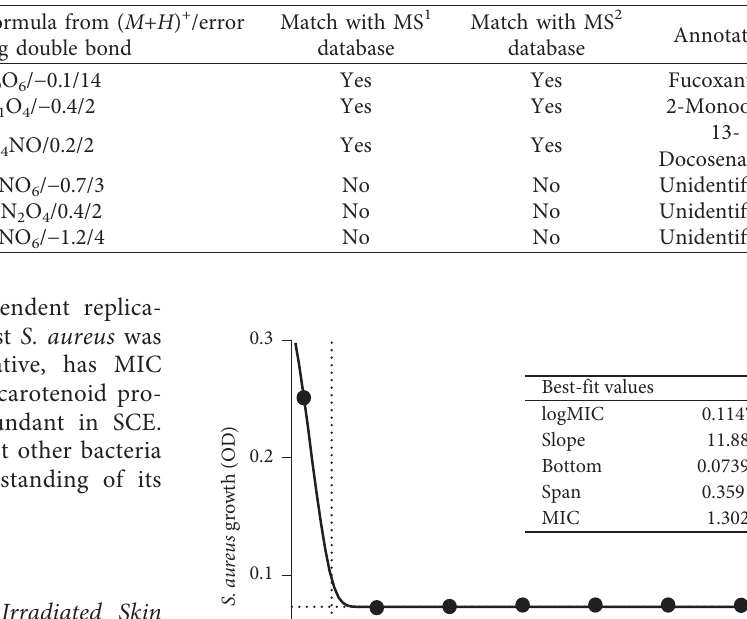
Figure 1: Morphological features of Sargassum cristaefolium . Table 2: Summary of bioactive compounds analysis based on MS 1 and MS 2 . The exact mass of HRMS spectra was compared with the available database of METLIN, Scifinder, PubChem, and GNPS. The MS2 data were submitted to high-throughput dereplication com- prehensive MS/MS libraries from GNPS (Supplementary Material, Figure S1–S6).